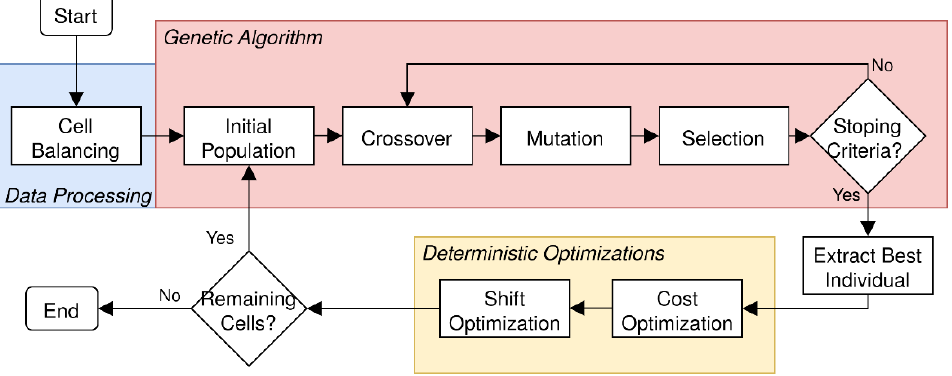
Figure 2. Flowchart of the production line energy cost optimization.